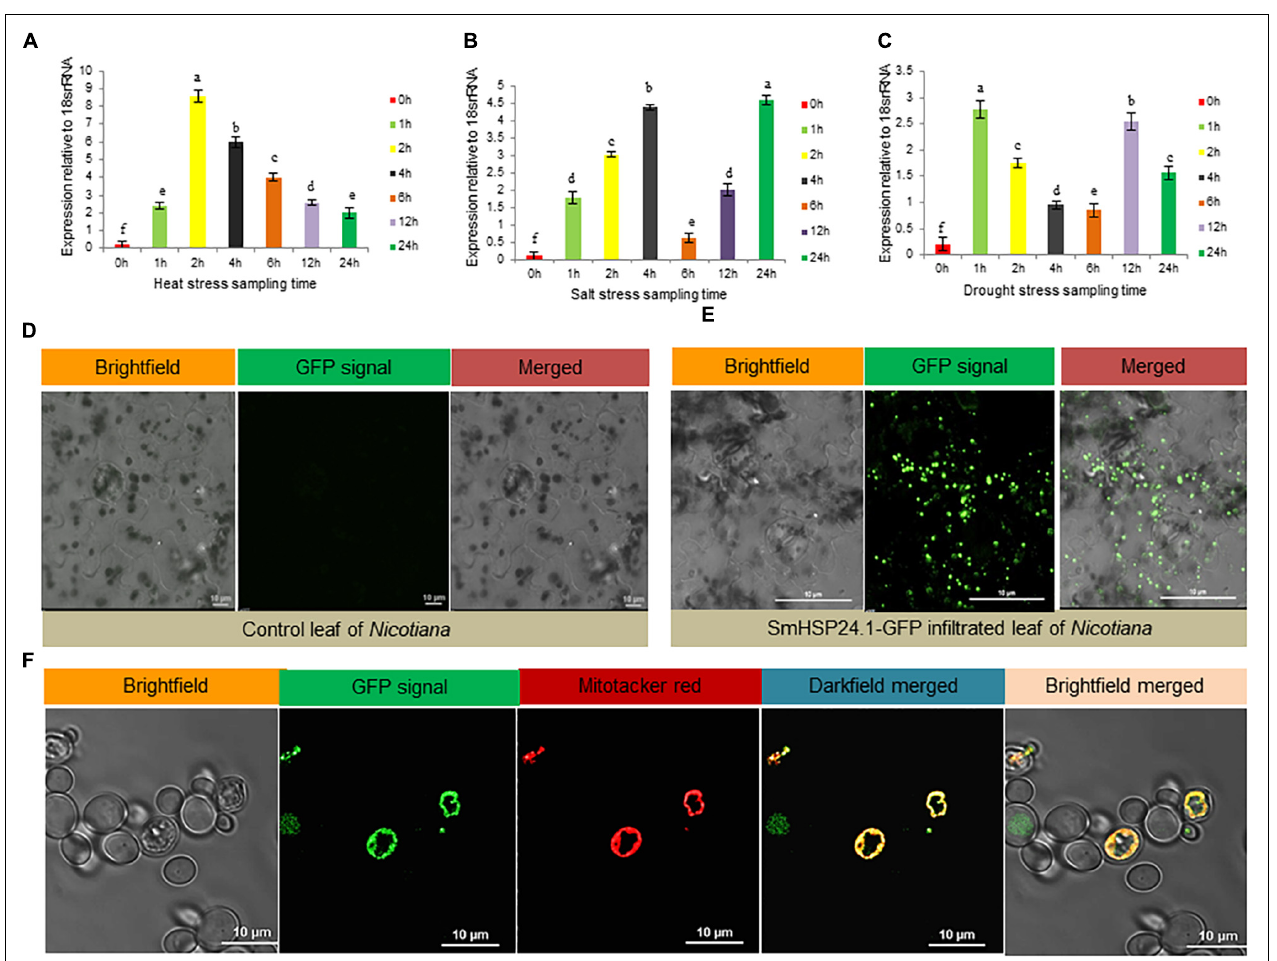
FIGURE 1 | Stress-responsive expression analysis and subcellular localization of SmsHSP24.1 protein. (A) Time-dependent relative quantitative RT-PCR analysis of 3-week-old eggplant seedlings grown in soil pot at 45 ◦ C heat. (B,C) Relative RT-PCR analysis of seedlings grown hydroponically in Yoshida nutrient solution containing 200 mM NaCl salt and 150 mM mannitol. RT-qPCR data are M ± SD ( n = 3). The letters a, b, c, and others indicate significant differences between samples ( P < 0.05). (D) Fluorescence scanning confocal microscopy of the Agro-infiltrated control tobacco epidermal cells appeared with no mGFP